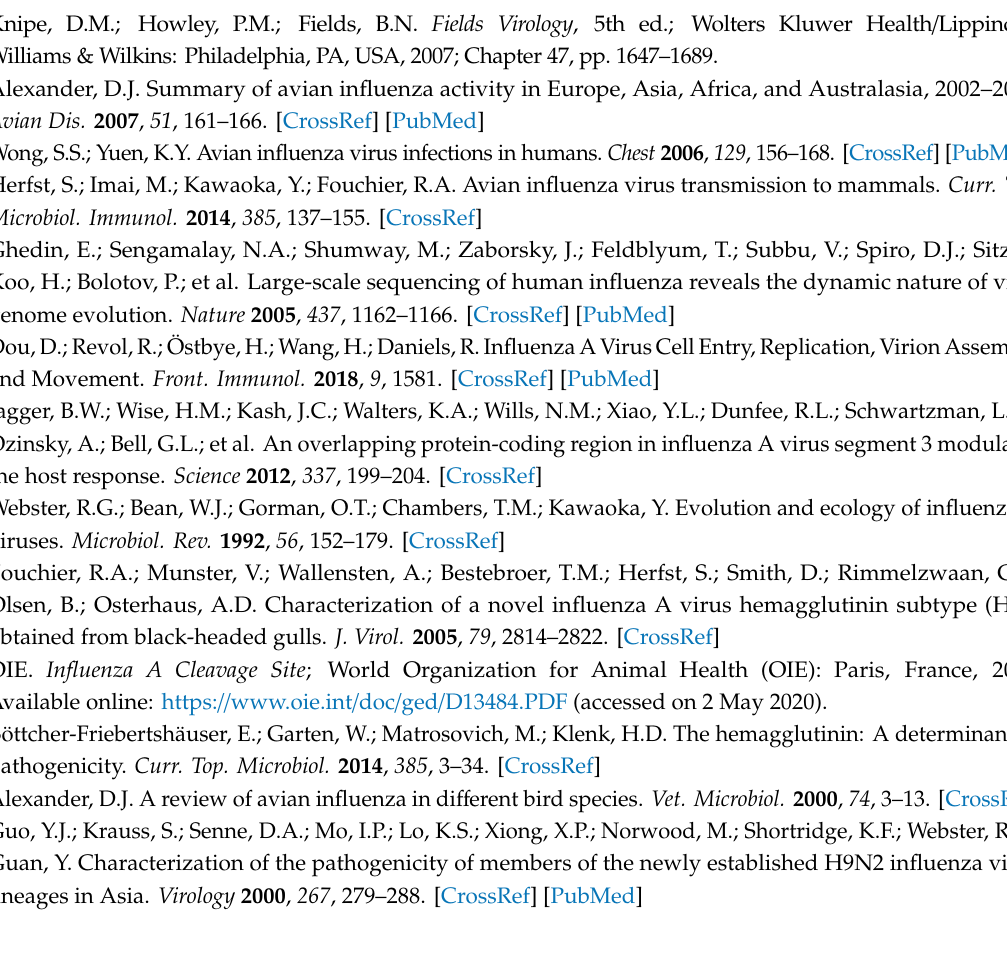
Figure S1: Phylogenetic relationship of HA genes of the Bangladeshi HP H5N1 (a) and LP H9N2 (b) viruses. The generation of trees has been detailed in the legend of Figure 3. Table S1: Avian influenza virus HA subtypes detected in Bangladesh (based on sequences available in public databases). Table S2: Avian influenza virus NA subtypes detected in Bangladesh (based on sequences available in public